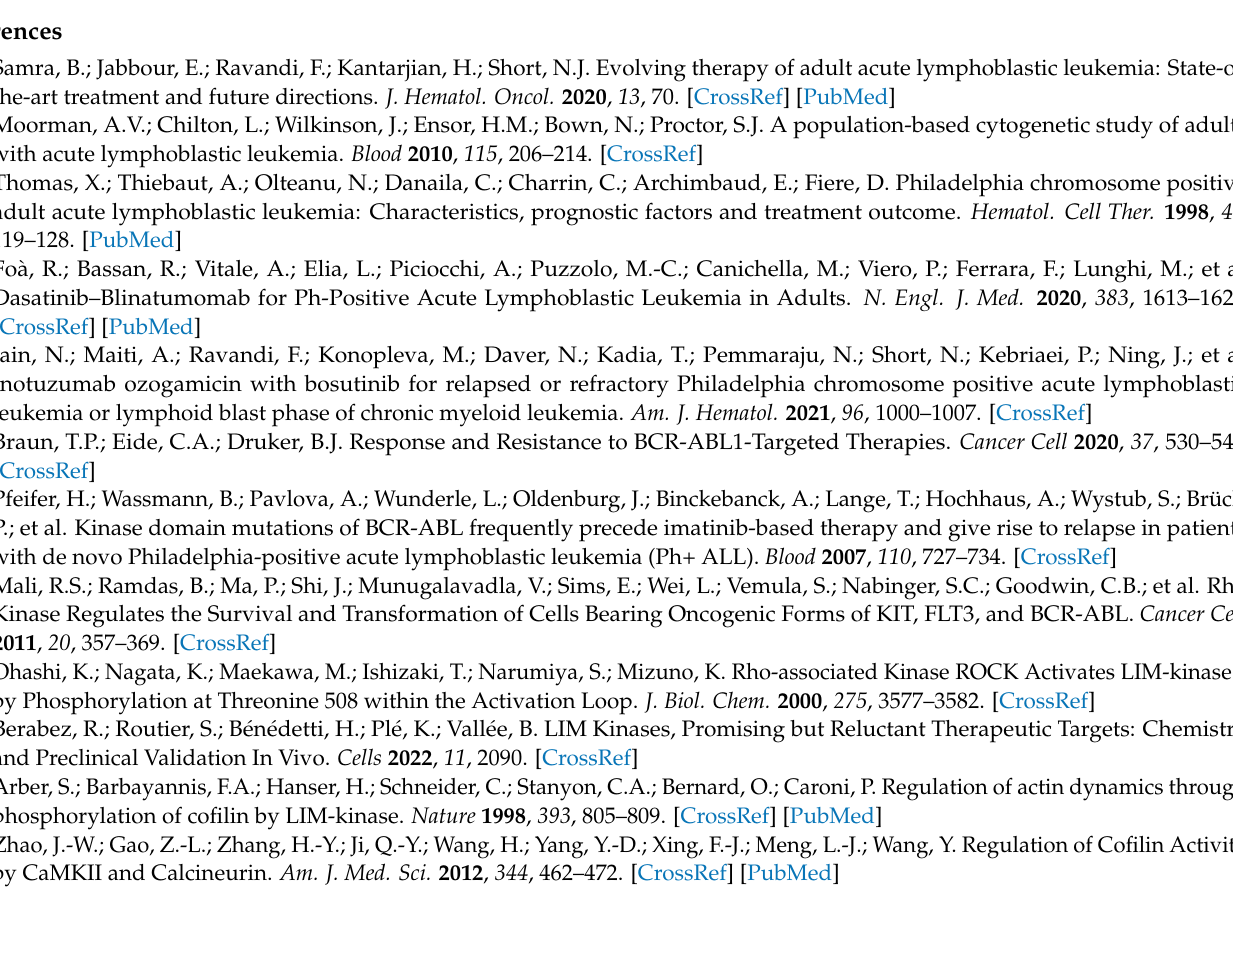
Table S2: Characteristics of patients; Figure S1: LIMK1, LIMK2, cofilin, and phospho-cofilin protein expression in BCR::ABL + B-ALL cell lines after TKI exposure; Figure S2: Effect of drug combinations with TKI on cell cycle in BCR::ABL+ ALL cell lines; Figure S3: Drug combinations of LIMKi with vincristin and dexamethasone in BCR::ABL ALL cell lines; Figure S4: Detection of GFP positive BCR::ABL+ blast cells in C57BL/6J